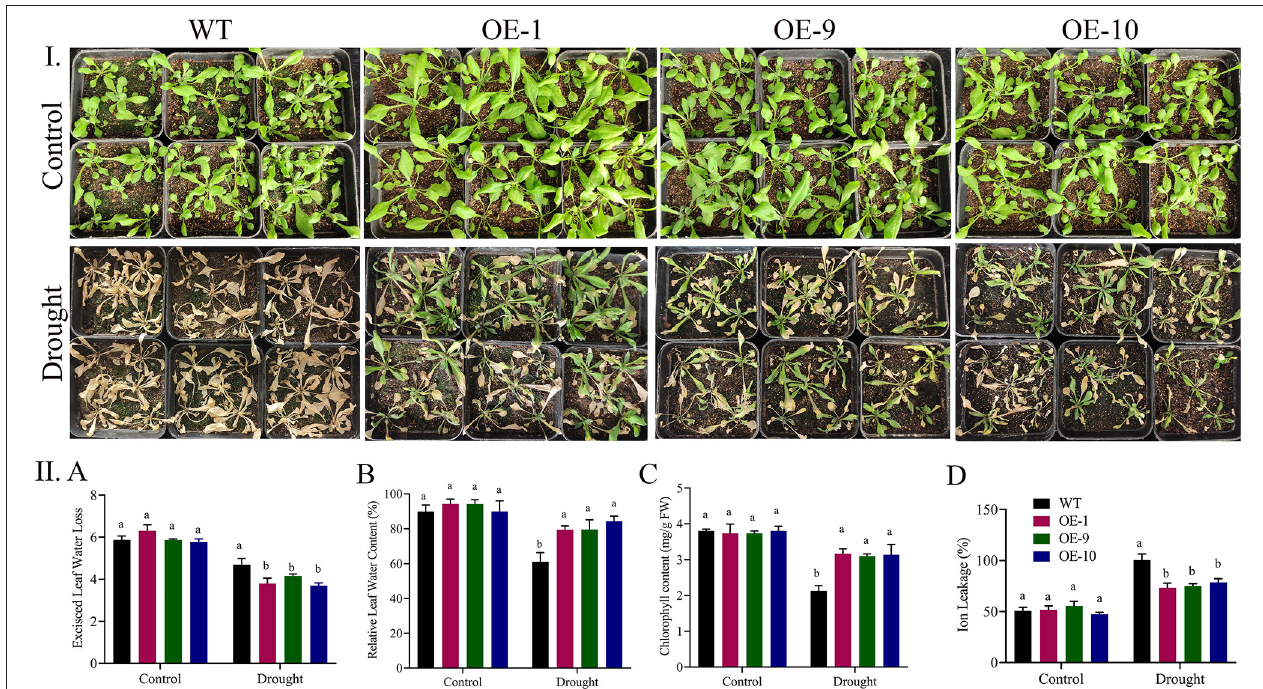
FIGURE 6 | (I) Physiological parameters evaluation in ALDH overexpressed lines under drought stress. (II) A Transgenic lines and wild type under control and treatment. A Relative leaf water content, B excised leaf water loss, C chlorophyll content, and D Ion leakage after drought stress treatment. The error bars reflect the SE. Significant differences were observed by different letters above the graphs (ANOVA, p < 0.05). WT, wild type; overexpressed lines (OE-1, OE-9, and OE-10) after 8-day stress treatment. Three replications were maintained in the experiment. ANOVA, analysis of variance; SE, standard